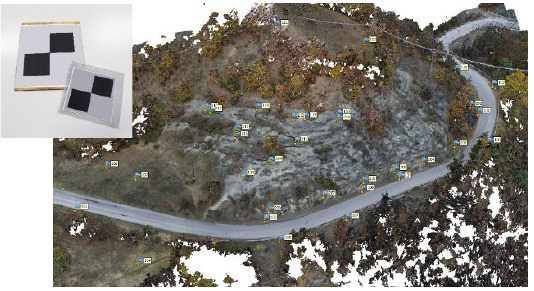
Figure 6. The GCPs location on the dense point cloud background; in the upper left corner an example of the used photogrammetric markers.